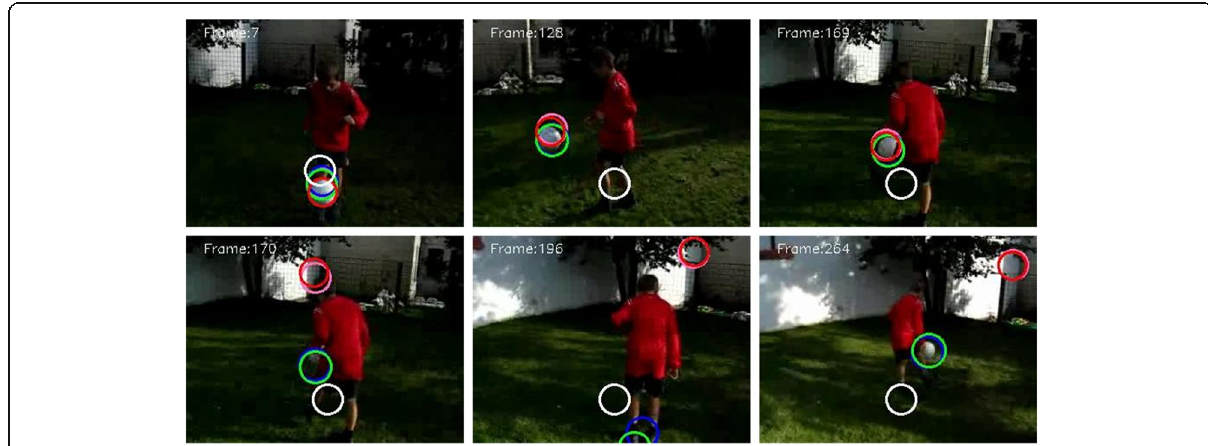
Fig. 27 The tracking failure example of video “ v_juggle_15_02 ” using CAM-Shift (white), PF (blue), VAPF (green), M-PF (pink), and the proposed tracker (red). Particle number N = 250